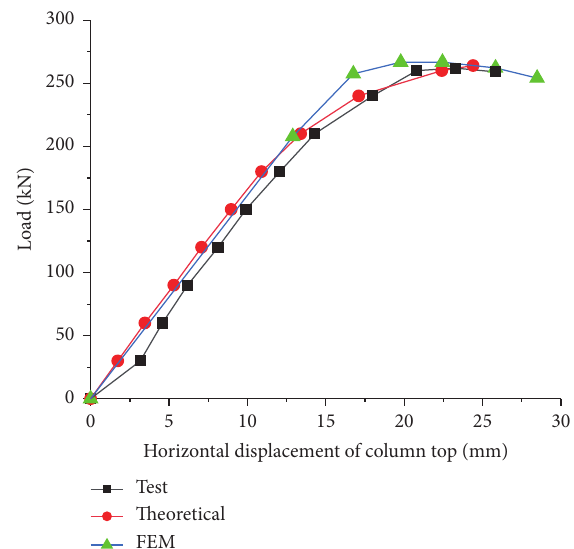
Figure 19: Comparison of load-displacement curves of steel col- umns under secondary